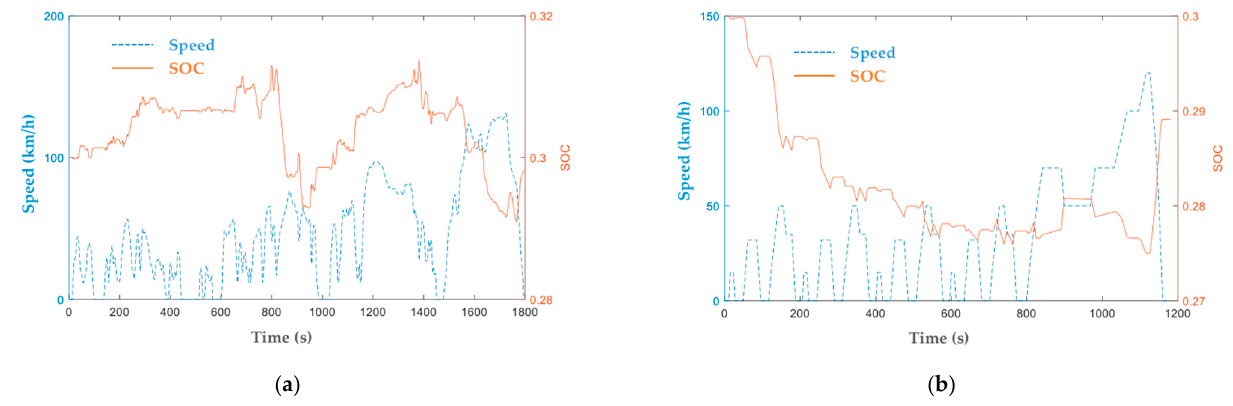
Figure 11. The curve of the speed and the SOC by using the optimized ECMS algorithm under the WLTC and the NEDC cycles: ( a ) Under the WLTC cycle; ( b ) Under the NEDC cycle.